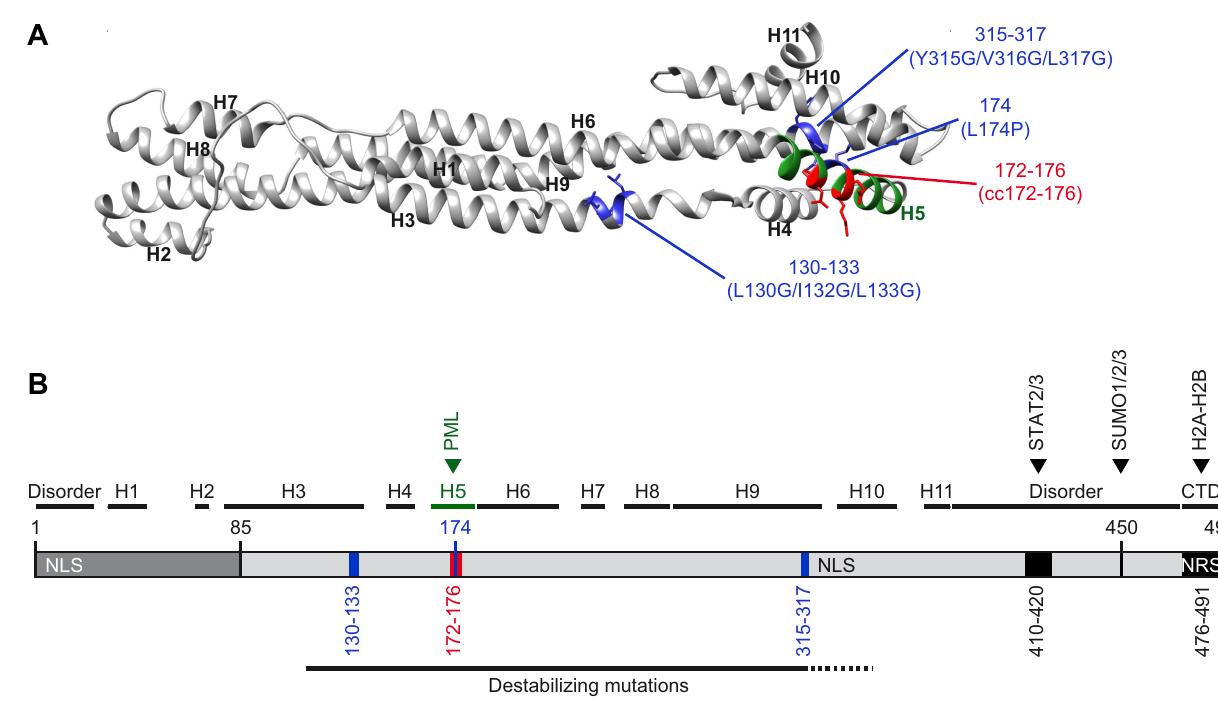
Fig 11. Helix5 as determinant of PML interaction and structure-stability relationship of IE1. (A) Tertiary protein structure of hCMV IE1 core domain modelled on the orthologous domain of rhCMV IE1 (PDB 4WID) [49] using Phyre2. The predicted α -helices (H1-H11) are indicated, including H5 involved in PML interaction shown in green. The residues including side chains relevant to mutations examined in this study are shown in blue and red. (B) Schematic of hCMV IE1 showing structural organization, including N-terminal segment shared with IE2 (amino acids 1–85), putative disordered regions, predicted α - helices (H1-H11) including H5 involved in PML interaction (green) and CTD. Residues relevant to mutations examined in this study (blue and red), binding sites for cellular proteins (PML, STAT2/STAT3, SUMO1-3, H2A-H2B) as well as two NLS and a putative nuclear retention signal (NRS) are shown alongside these structural features and select amino acid positions. The segment of the IE1 core domain (H3-H9/H10) proposed to be particularly sensitive to protein destabilizing mutations is indicated as